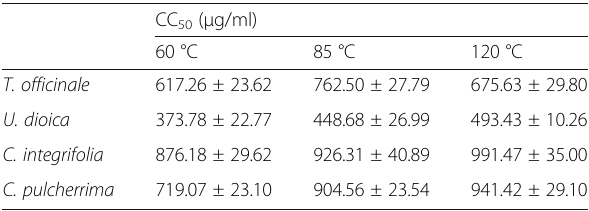
Table 1 Cytotoxic concentration 50 (CC 50 ) of the aqueous extracts to 60, 85 and 120 °C